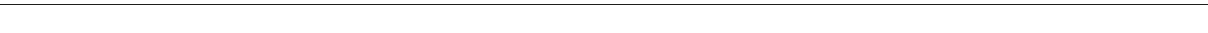
Fig. 4 Structural and mechanical contraction kinetics of PRP-clots. a Serial confocal images showing time-dependent densi fi cation of the fi brin network; Scale bar : 60 μ m. b Dynamic fi brin fl uorescence intensity per square micrometer as a measure of fi brin densi fi cation ( black solid line ) characterized by three phases determined by the local extremes of the fi rst derivative ( blue dashed line and vertical dashed borders between the phases). The phase designations shown here correspond to the phases P 1 − P 4 shown in Fig. 1b. c Fibrin densi fi cation as a function of time in the absence and presence of blebbistatin (300 µ M) and abciximab (100 µ g/ml) (mean ± SD, n = 3). d Fibrin fl uorescence intensity ( fi brin density) at the end of contraction in the absence and presence of blebbistatin (300 µ M) and abciximab (100 µ g/ml) (mean ± SD, n = 3, **** P < 0.0001, a two-tailed Mann − Whitney test). e Dynamic contractile stress generated by the platelet- fi brin meshwork in the absence and presence of 100 µ g/ml abciximab, a speci fi c antagonist of the platelet receptor integrin α IIb β 3 (averaged kinetic curves, n = 3, mean ± SD). f The kinetic curve shown in e has four phases ( P corresponds to the pre-contraction stage with the rate constant k 1 ; P 2 A and P 2 B comprise the fastest phases with the rate constants k 2 and k 3 , respectively; and P 3 is the fi nal contraction phase with the rate constant k 4 . g , h The storage and loss moduli of fully contracted PRP-clots (50 min) in the absence and